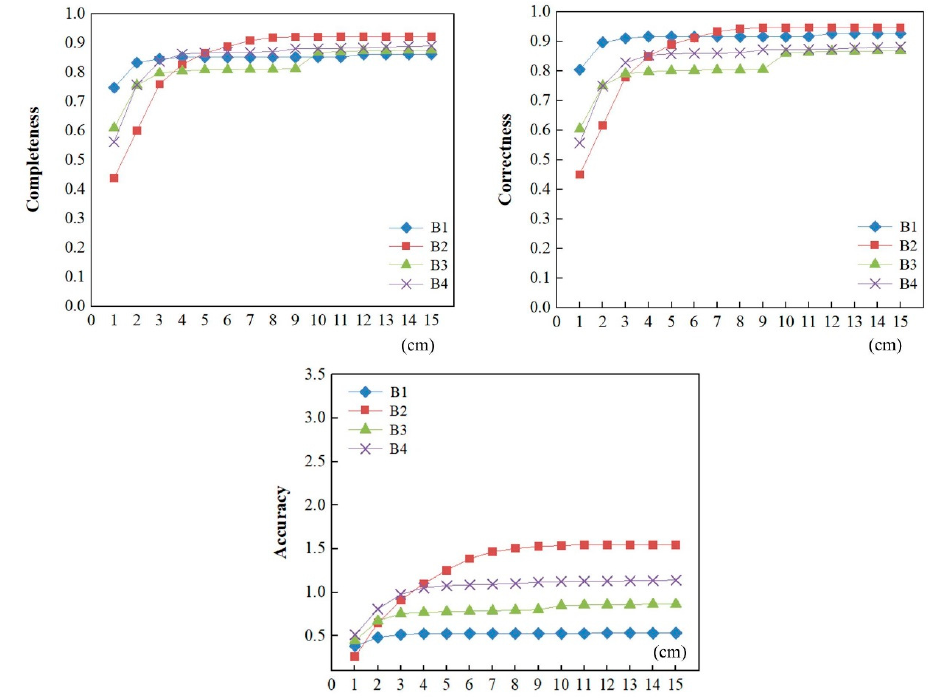
Figure 10. Evaluation results for the reconstructed polygon model on completeness, correctness and accuracy. Table 7. Evaluation results for mesh datasets.